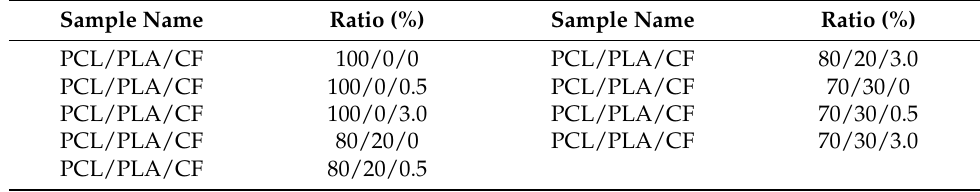
Table 2. Sample names and blend